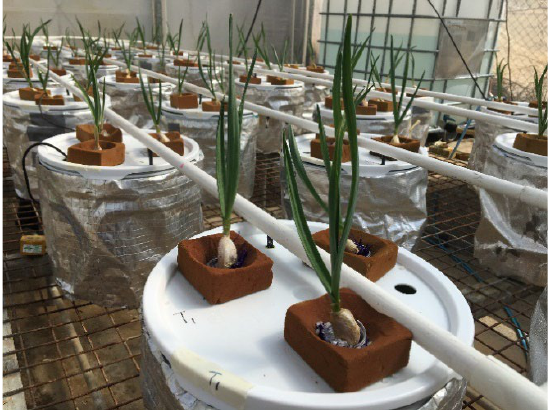
Figure 4. Garlic cloves were grown in solution culture in a glasshouse at Gatton campus, The Uni- versity of Queensland, Australia in 2020. University of Queensland, Australia in